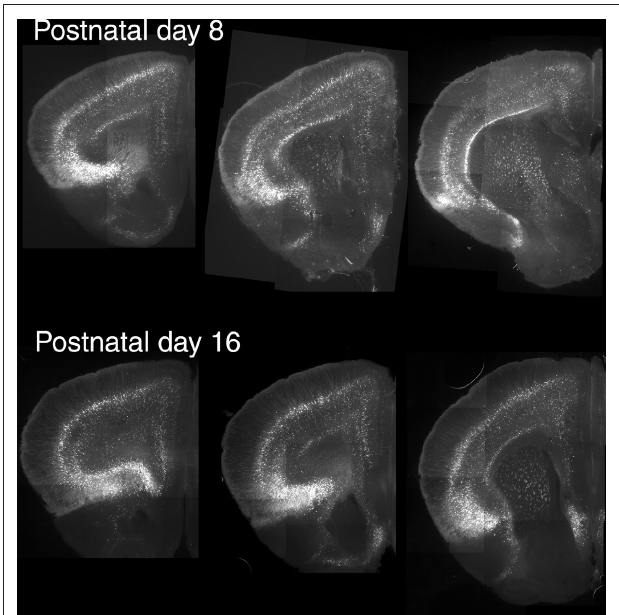
Figure 3 | expression of egFP in the anterior cerebral cortex during the early postnatal period. For these experiments EGFP was immunolocalized in horizontal sections using a rabbit anti-GFP antibody and detected using an Alexa 488 conjugated secondary goat anti-rabbit antibody. Mosaic composite images for each section were assembled from 9–12 subfields acquired with a digital